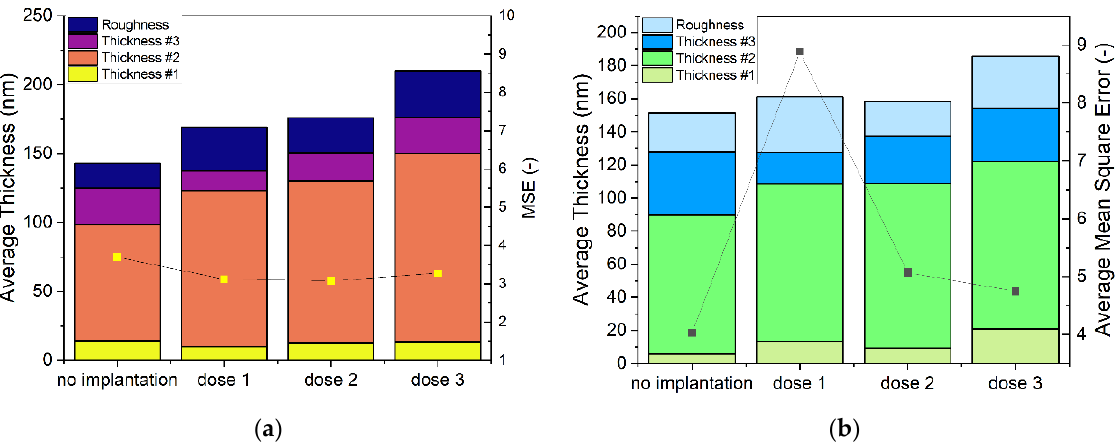
Figure 5. Thickness and fit figure of merit—mean squared error of fits performed for ( a ) representative points of maps, ( b ) whole maps.